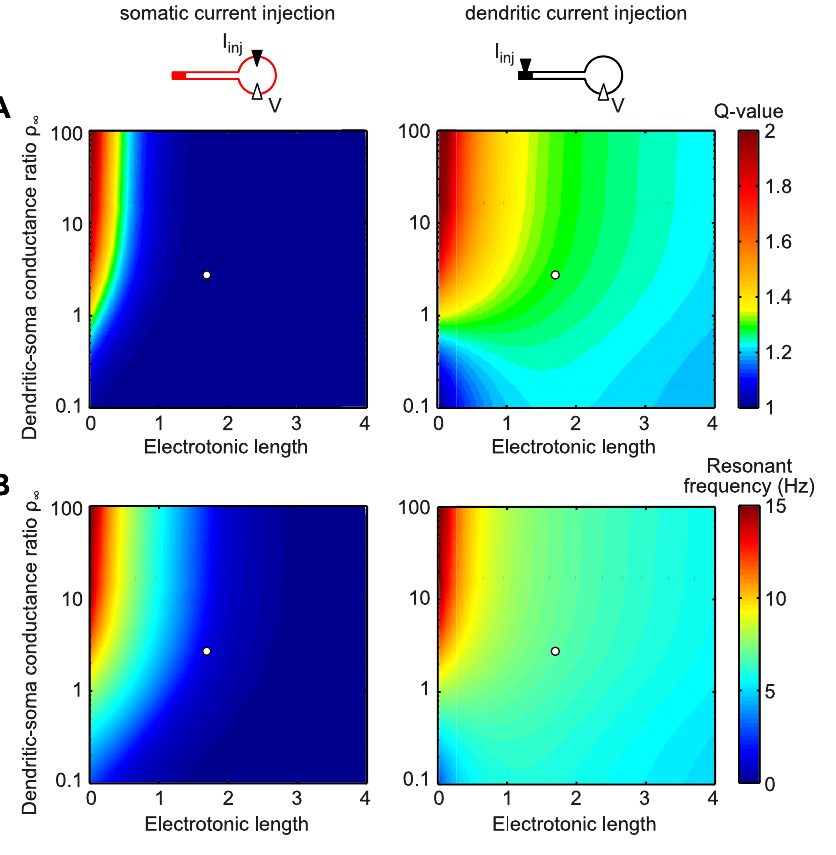
Figure 4. For electrotonically large cells the origin of input determines the ‘‘visibility’’ of dendritic resonance in somatic measurements. Color-coded Q-value (A) and resonant frequency (B) of the somatic input impedance (left panels) and the dendro-somatic transfer impedance (right panels). The somatic input impedance exhibited a resonance only for short electrotonic lengths and large dendritic-soma conductance ratios r ? . In contrast, the transfer impedance showed a resonance across the whole parameter range with the exception of cells that are electrotonically small and have a low dendritic-soma conductance ratio. White circles correspond to the default model with electrotonic length L ~ 1 : 7 and conductance ratio r ? ~ 2 : 7 .